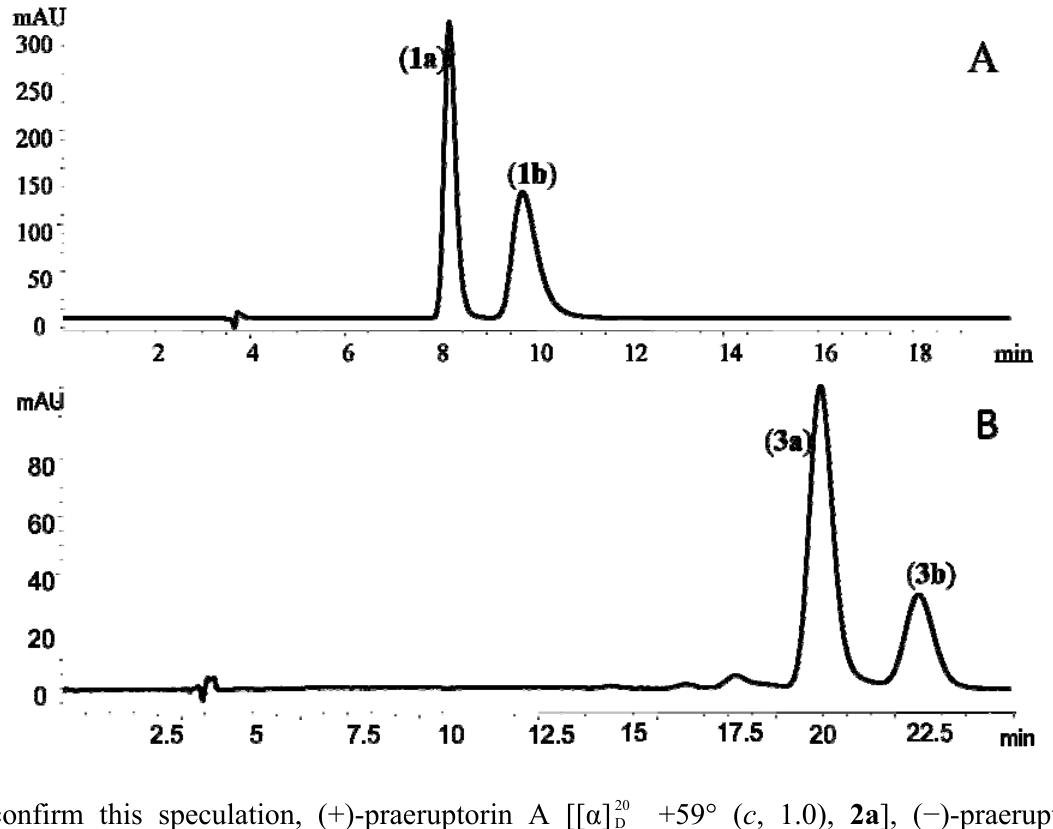
Figure 2. Typical HPLC-UV (323 nm) chromatograms of compounds 1 (A) and 3 (B) on a CHIRALPAK AD-RH semi-preparative column.